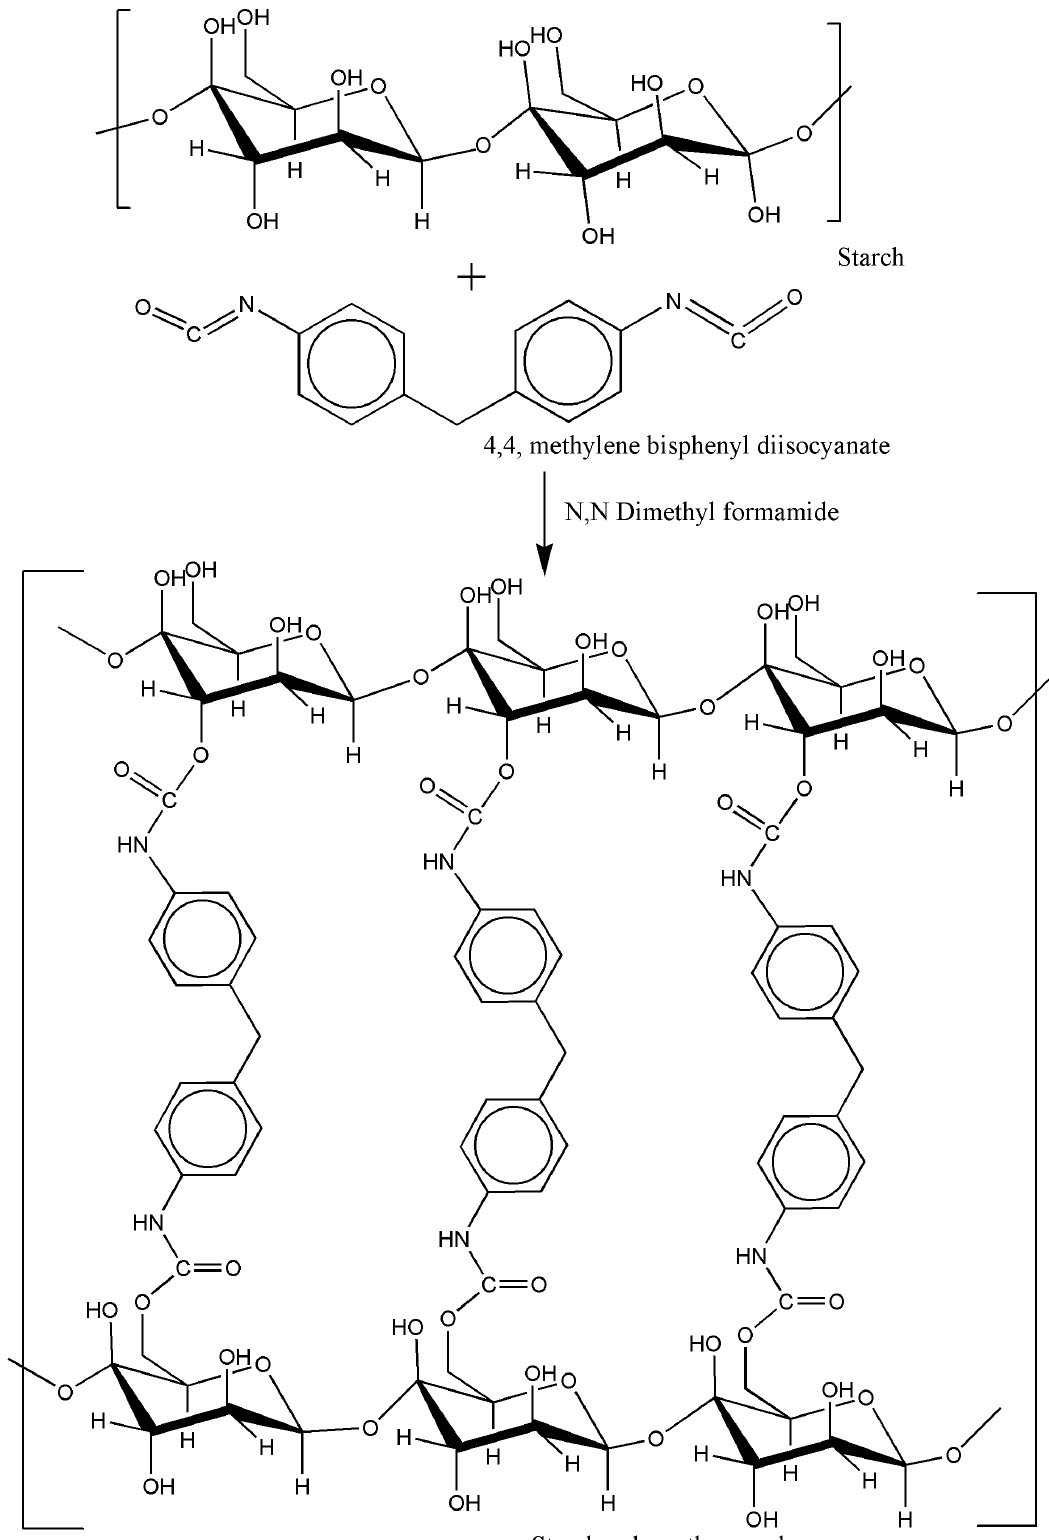
Scheme 1. Synthesis scheme of starch polyurethane